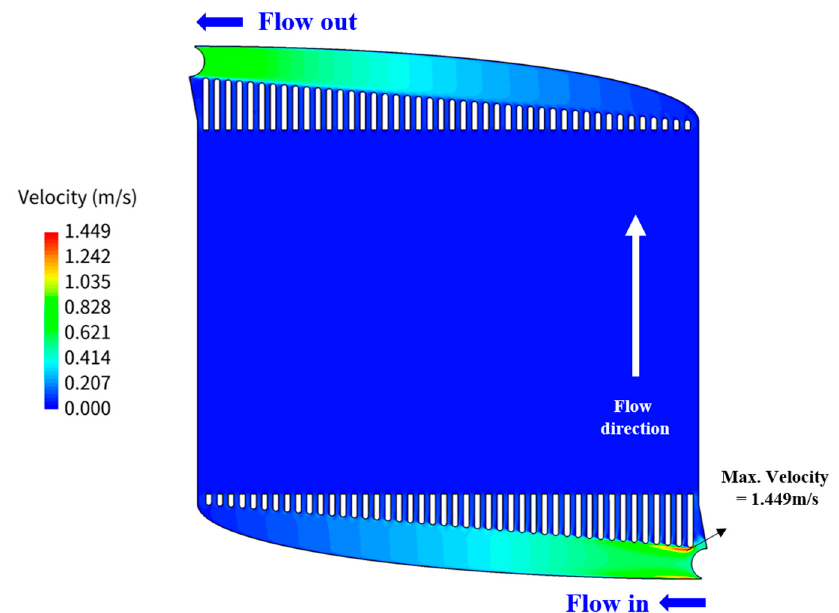
Figure 14. Flow distribution for CASE 1. Table 6. The difference in pressure drop between conventional design and CASE 1.